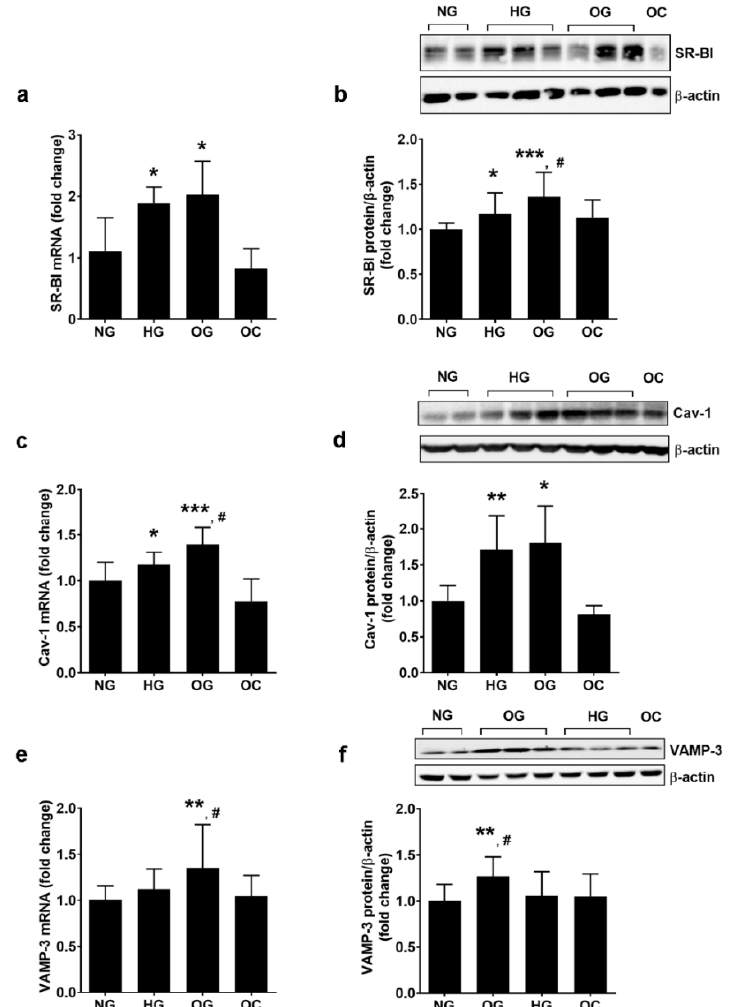
Figure 4. Oscillating glucose alters the expression of proteins involved in transendothelial transport of molecules. Cells were exposed to 5 mM glucose (NG), 25 mM glucose (HG) or alternatively to 5 mM/25 mM glucose (OG) at every 3 h, for 72 h. Cells exposed alternatively to L -glucose or mannitol (using the same protocol as for OG) was considered osmotic control (OC). ( a , c , e ) mRNA levels of SR-BI ( a ), Cav-1 ( c ) and VAMP-3 ( e ); ( b , d , f ) protein expression of SR-BI ( b ), Cav-1 ( d ) and VAMP-3 ( f ) in EC lysates relative to β -actin (representative blot and densitometric analysis). All data are expressed as fold change versus NG and presented as mean ± SD. * p < 0.05, ** p < 0.01, *** p < 0.001 vs. NG; # p < 0.05 vs.